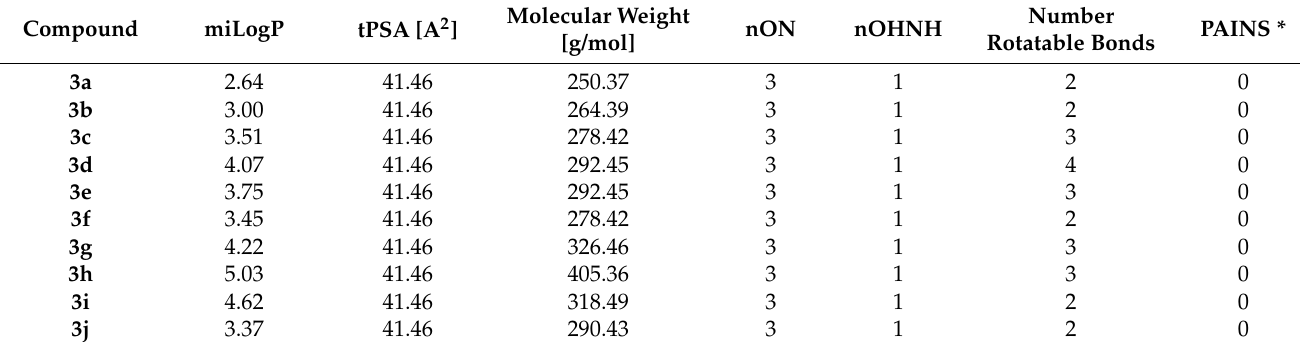
Table 3. Physicochemical properties of the obtained series of 2-(adamantylamino)thiazol-4(5 H )-one derivatives. Compound miLogP tPSA [A 2 ]